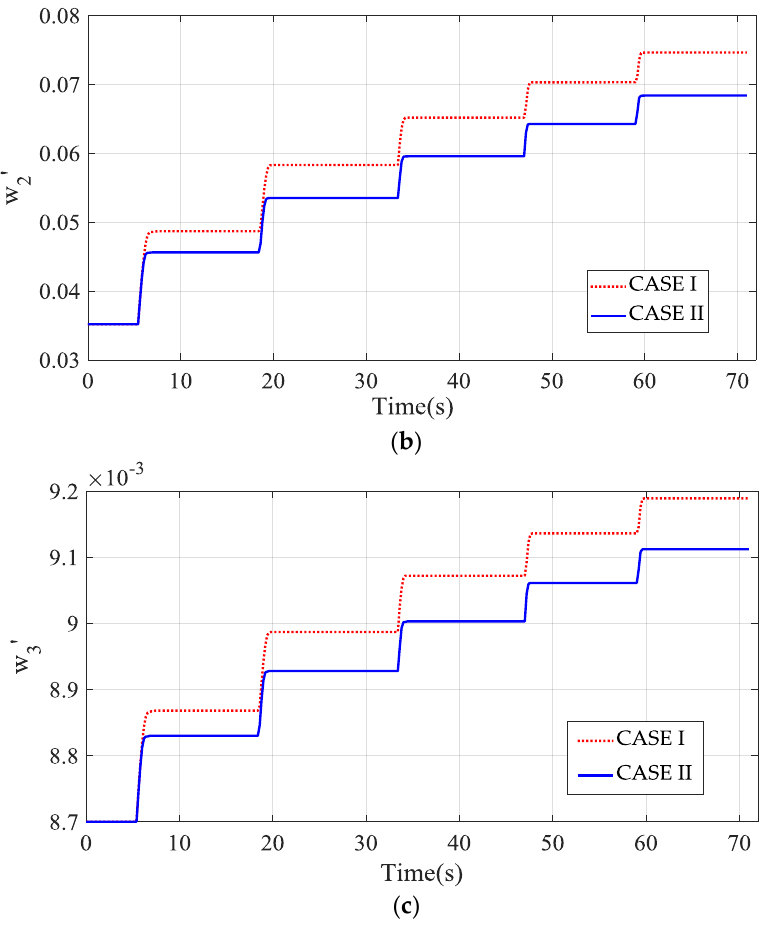
Figure 15. The time history of three weights in the two cases. ( a ) 𝑤 1′ ; ( b ) 𝑤 2′ ; ( c ) 𝑤 3′ .